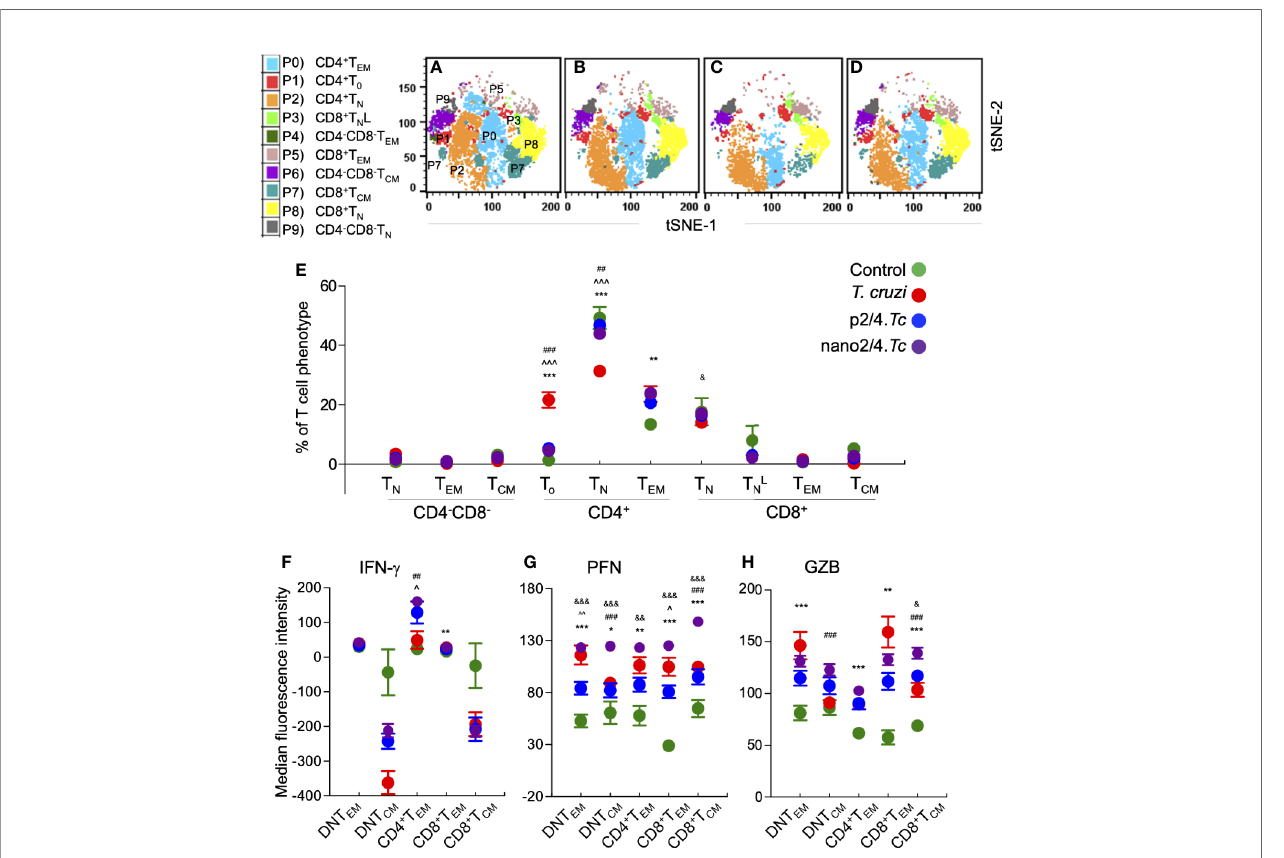
FIGURE 2 | Flow cytometry analysis of T cell pro fi le in mice at early phase of T. cruzi infection (± nanovaccine). C57BL/6 mice were immunized, infected, and euthanized on day 10 pi, as described in Figure 1A . Splenocytes were labeled with fl uorescent-conjugated antibodies and analyzed by fl ow cytometry. FlowSOM analysis of CD3 + splenic T cells of mice based on the expression levels of CD4, CD8, CD25, CD62L, and CD44 antigens generated self-organizing ten meta-clusters (referred as P0 – P9). (A – D) The tSNE (t-distributed stochastic neighbor embedding) plots were generated with non-linear reduction method to visualize all the 10 sub- populations in two-dimensional space in non-vaccinated/non-infected (A) , non-vaccinated/infected (B) , p2/4. Tc (C) , and nano2/4. Tc (D) groups of mice. (E) Bar graph shows P0 – P9 sub-populations of T cells in all four groups of mice. (F – H) Median fl uorescent intensity was calculated for intracellular cytokine (IFN-g) and markers of T cell cytotoxicity [perforin (PFN) and granzyme B (GZB)] in T effector/effector memory (T EM ) and T central memory (T CM ) subsets. All data are derived from n = 5 – 10 mice per group (at least duplicate observations per sample) and plotted as mean values ± SEM. Signi fi cance is presented as described in Figure 1 . Detailed data (mean values ± SEM and signi fi cance) are shown in Tables S2A and S3A